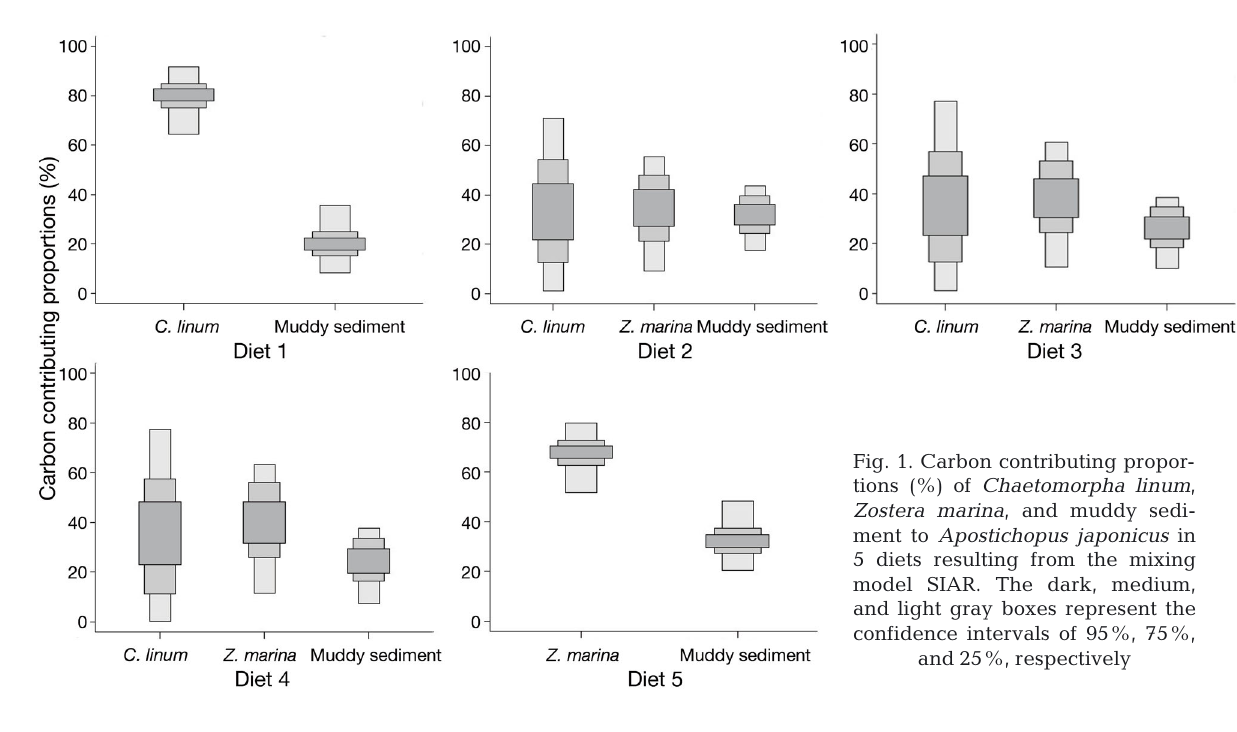
Fig. 1. Carbon contributing propor- tions (%) of Chaetomorpha linum , Zostera marina , and muddy sedi- ment to Apostichopus japonicus in 5 diets resulting from the mixing model SIAR. The dark, medium, and light gray boxes represent the confidence intervals of 95%, 75%, and 25%, respectively